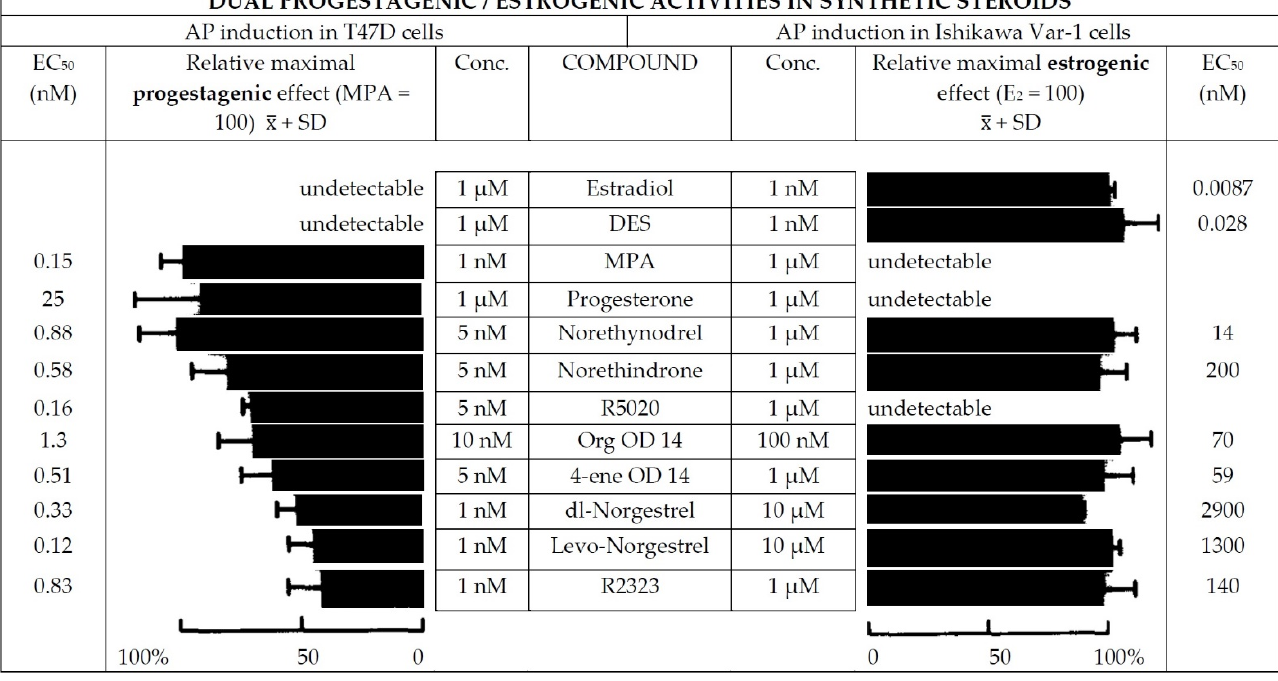
Figure 1. Progestagenic and estrogenic activity of various progestins. Reprinted from Ref. [114]. Copyright 1994, with permission from Elsevier.